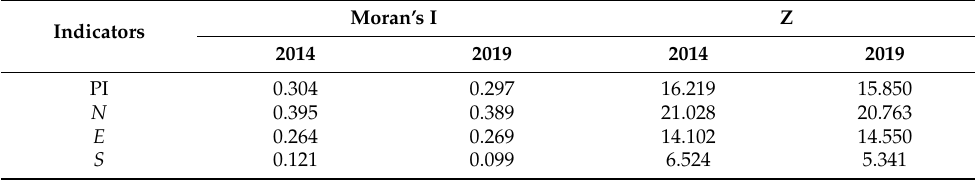
Table 2. Spatial autocorrelation test of the Poverty Index of PA counties.